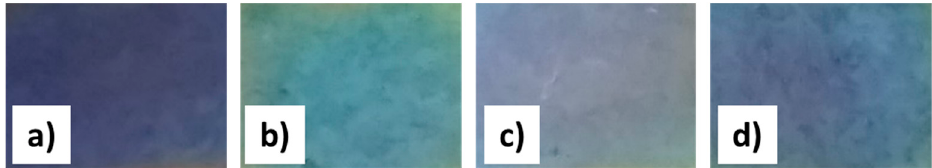
Figure 8. Real color images of a cropped area of complex 5 -loaded paper strips after adding cell- conditioned media. Complex 5 -loaded paper strip treated with non-conditioned medium ( a ), cell- conditioned medium ( b ), non-conditioned medium +800 µM H 2 O 2 ( c ) and cell-conditioned medium after 1 h treatment of the HepG2 cells with 800 µM H 2 O 2 ( d ). Original non-cropped images are re- ported in SI (Figure S25).